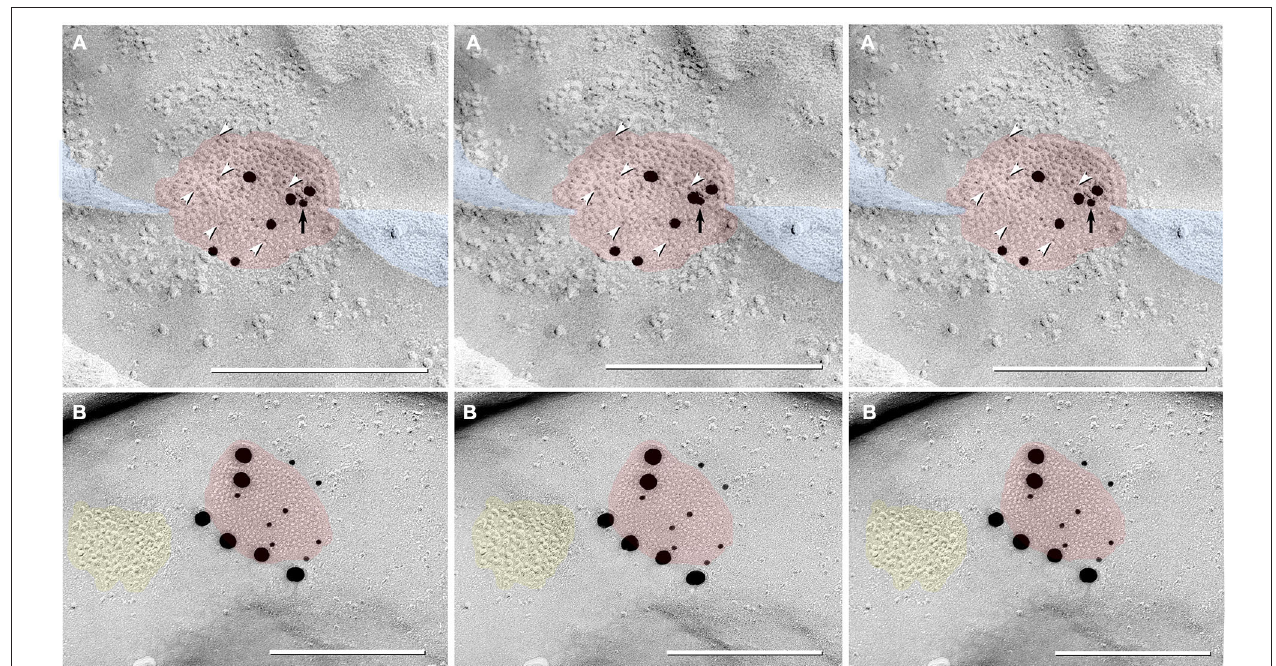
where labeling is not possible. Note the narrowing of the extracellular space ( blue overlay ) at the point of closest membrane approach within the gap junction. (B) E-face image of gap junction plaque ( red overlay ) labeled for Cx36 (36–4600) by eight 12-nm gold beads and six 30-nm gold beads. Because of greatly different amino acid sequences in fish vs. mammalian glutamate receptors (see text), the immediately adjacent cluster of glutamate receptor-like E-face IMPs ( yellow overlay ) does not exhibit labeling for GluR2 (6-nm and 18-nm gold beads, none present). Calibration bars are 0.25 µ